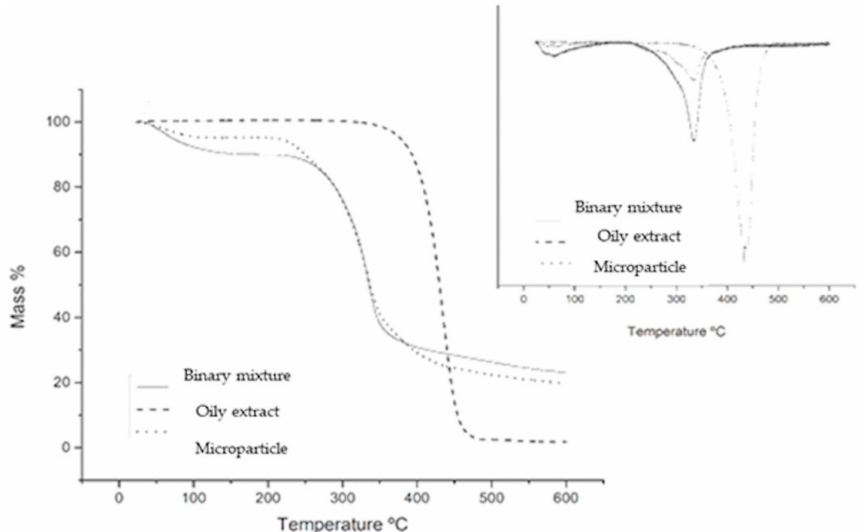
Figure 2. TG/DTG curve of binary mixture of adjuvants, the oily extract and microparticle. Condi- tions: nitrogen atmosphere (N 2 ), the flow of 50 mL/min, and a heating rate of 10 ◦ C/min. Among the three samples, the oily extract showed the lowest percentage of residue, only 2.175%, and the greatest loss of mass, which indicates its lower thermal